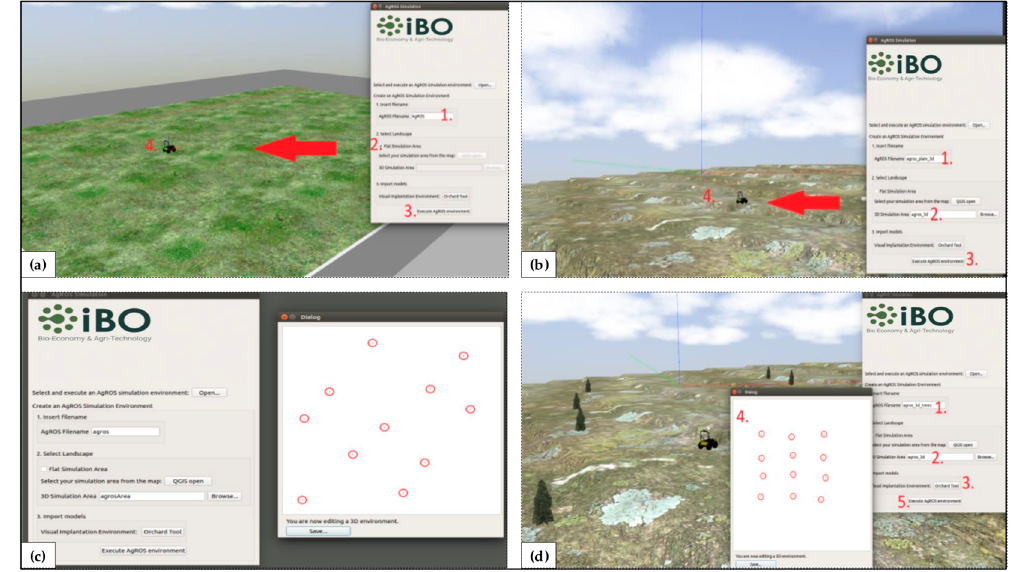
Figure 5. Functionalities of the AgROS graphical user interface: ( a ) insert a flat landscape; ( b ) insert a 3D landscape; ( c ) import agricultural models (e.g., trees); and ( d ) emulate the integrated field